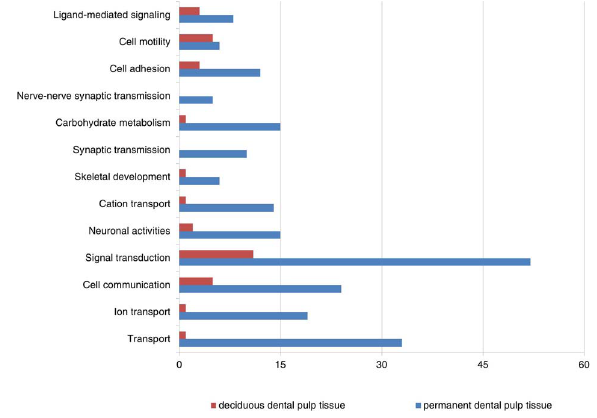
Figure 1. M-A plot. Expand this figure legend to explain what it means to those who might not be familiar with such a plot. The data of all plots were normally distributed.